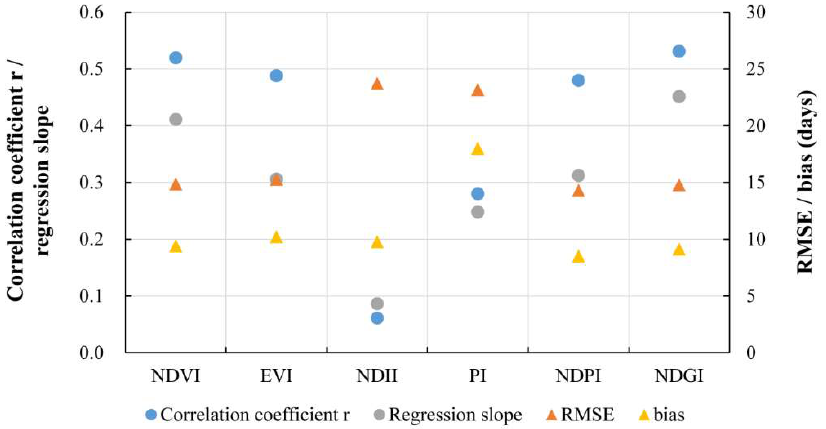
Figure 4. Correlation coefficient r, regression slope, RMSE, and bias between ground-observed GUD and satellite-observed GUDs detected from six VIs, each of which combined with four extraction methods.